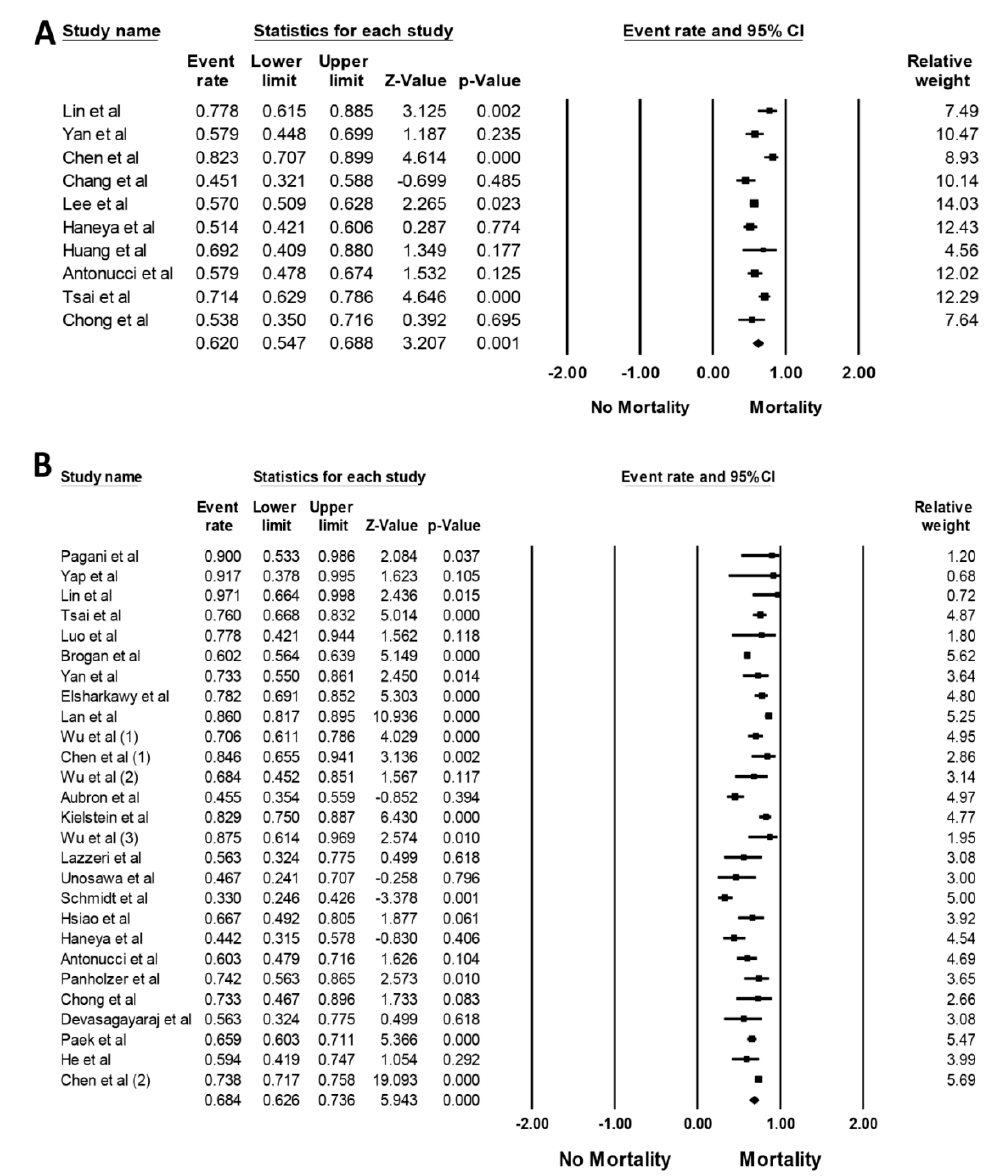
Figure 4. Forest plots of the included studies assessing ( A ) mortality rate of patients with AKI while on ECMO and ( B ) mortality rate of patients with severe AKI requiring RRT while on ECMO. A diamond data label serves as the overall rate from each study (square data marker) and 95%CI. Table 2. Characteristics of studies included in this meta-analysis of AKI associated mortality risk among patients requiring ECMO.